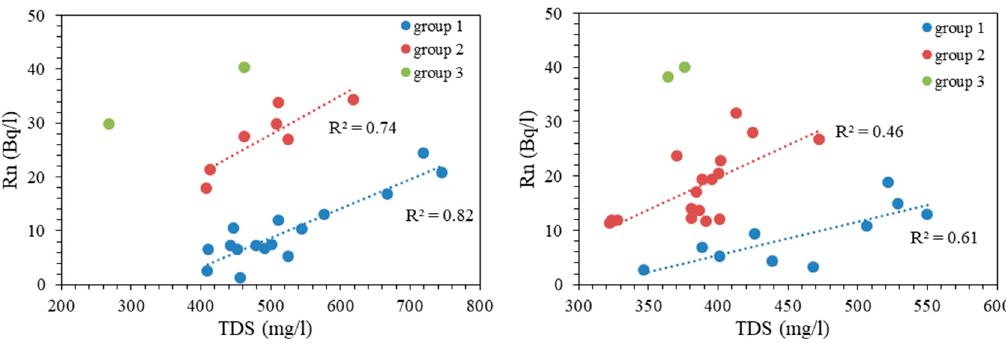
Figure 6. Relationship between 222 Rn with TDS for groundwater in May ( left ) and October ( right ).